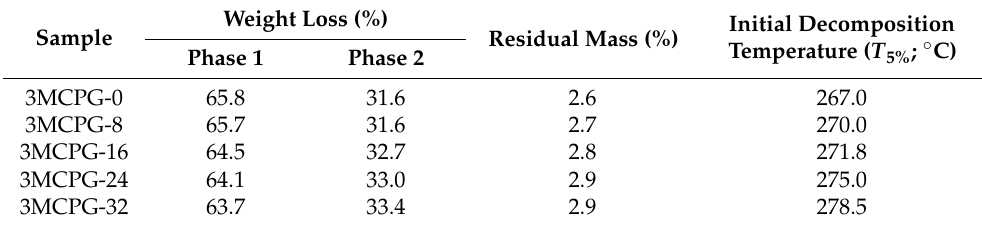
Figure 8. ( a ) TGA and ( b ) DSC curves of the MPU/AO ‐ 80 composites. Table 2. TGA data of the MPU/AO ‐ 80 composites.